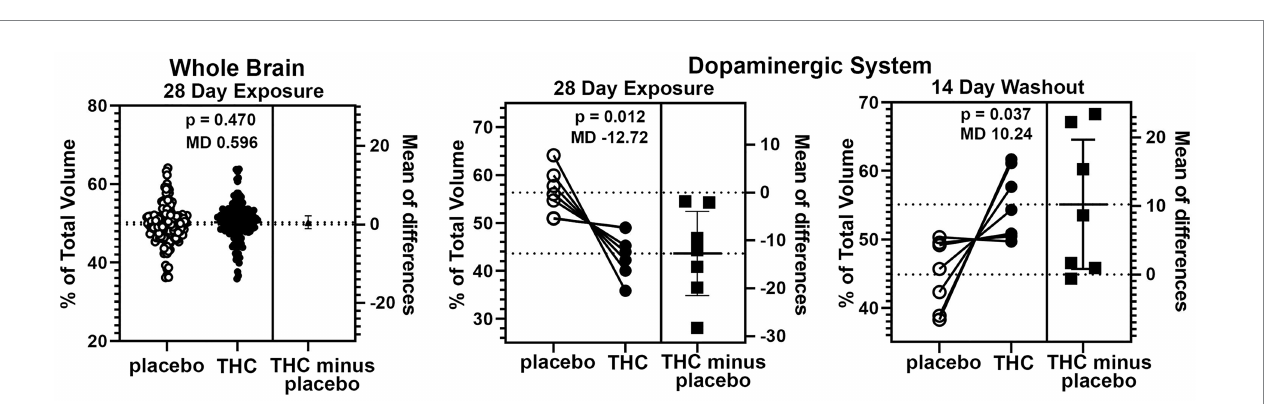
FIGURE 5 Voxel based morphometry. The scatter plot of the whole brain shows percent of the total volume for 139 brain areas. To normalize the data and correct for large differences in brain volumes between areas the mean percent difference between brain areas was calculated. So each open circle has a matching closed circle and together they equal 100%. All differences between the placebo condition and those for Δ 9-THC were compared with a paired t-test. There was no significant difference ( p = 0.470) with a mean difference (MD) of 0.596. between placebo and Δ 9-THC for the whole brain after 28 days of exposure. This is in contrast to the dopaminergic system comprised of the ventral tegmental area, substantia nigra, caudate/putamen, olfactory tubercles, ventral pallidum, accumbens core and shell. In every brain area, the mice exposed to Δ 9-THC had percent brain volumes significantly lower ( p = 0.012) than mice exposed to placebo with a mean difference of-12.17. These same brain areas are significantly larger ( p = 0.037) with a mean difference of 10.24 than the placebo after the two-week washout of Δ